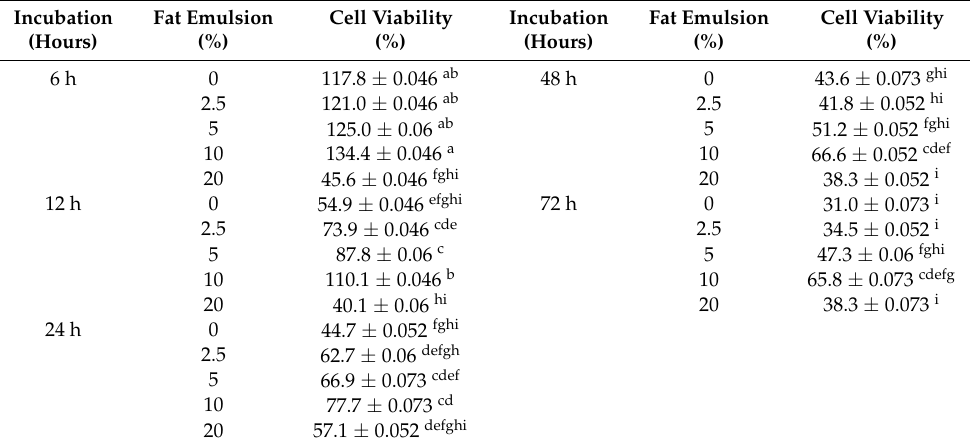
Table 2. Effect of different concentrations of fat emulsion on hepatocyte viability at different times.